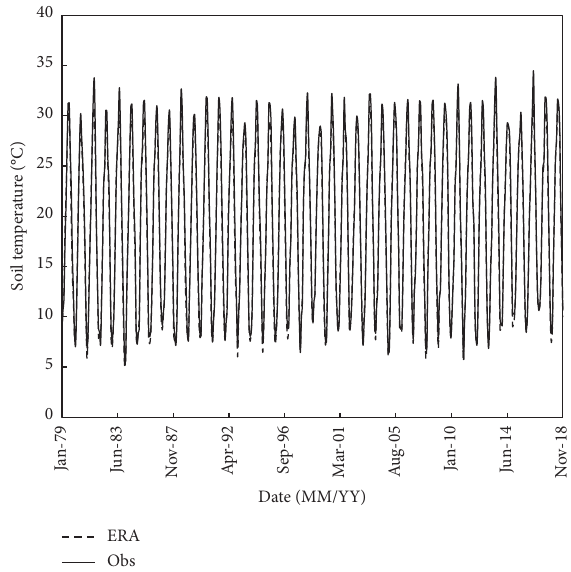
Figure 2: Monthly variations in ERA ST1 and obs. ST1 at Nan- chang